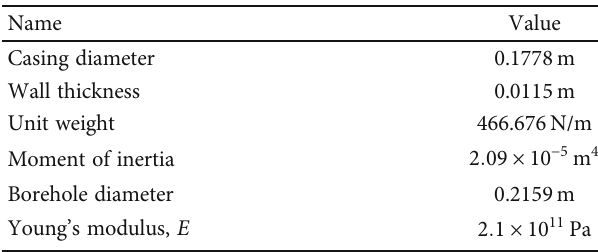
Table 4: Casing string combination parameters.